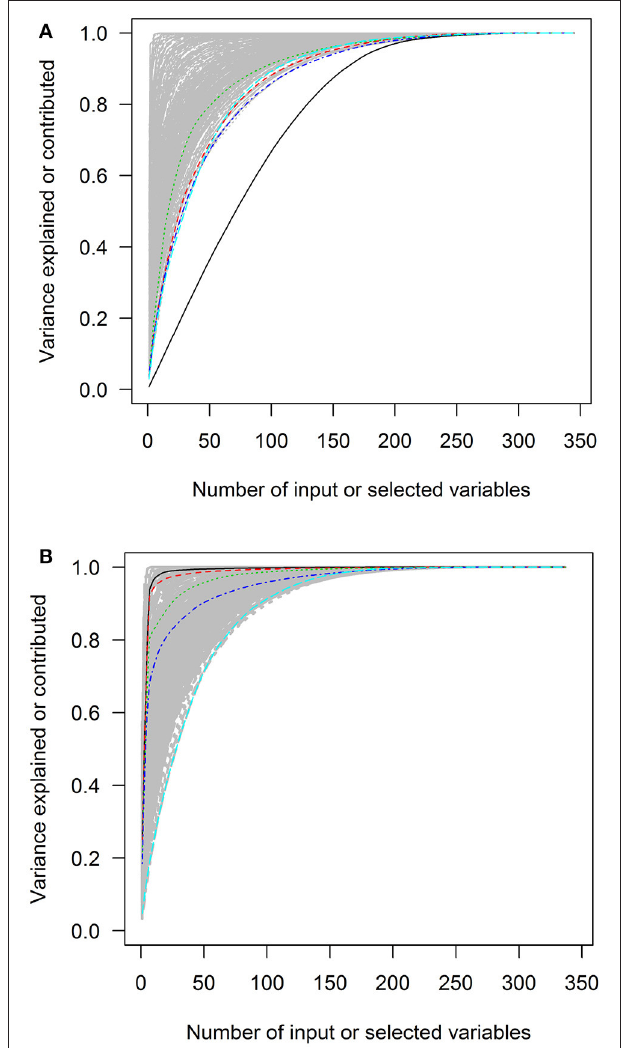
FIGURE 4 | The squared loadings in each PC and the R squared of PC approximation in the Medical Expenditure Panel 1996–2011 panel data. (A) The squared loadings of all variables in PCs. (B) The adjusted R squared of the variables that were used to approximate PCs. PC, principal component. Black, first PC; red, second PC, green; third PC; blue, fourth PC; light blue, fifth PC.